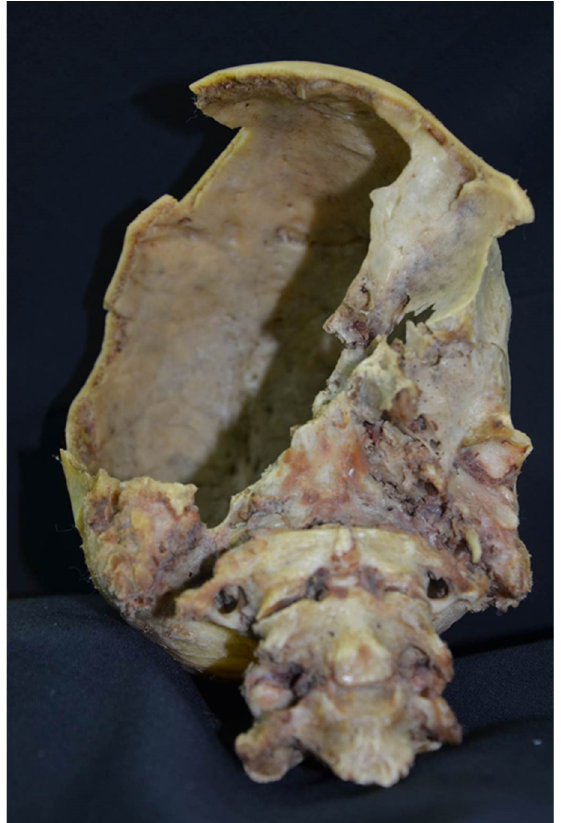
Figure 3. The skeletal reduction findings showed that the skull had fractures on the frontal, temporal, parietal, and occipital right side. The margins of all the fractures of the head showed macroscopic characteristics of vitality.